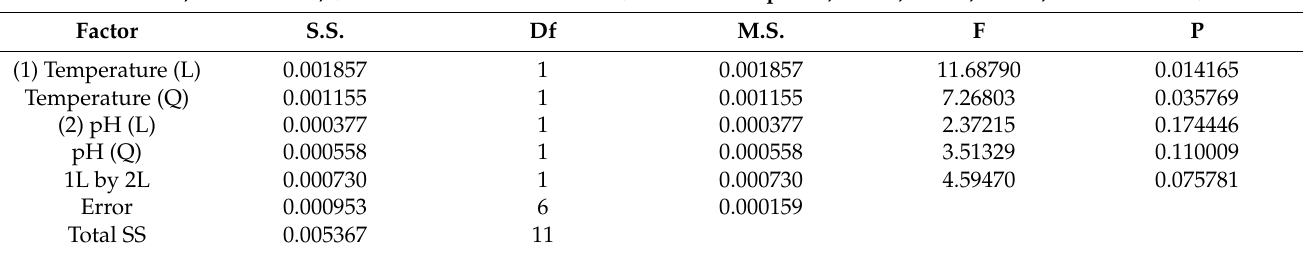
Table 3. Analysis of variance (ANOVA) results for the developed model, correlating esterase activity to reaction temperature and pH.